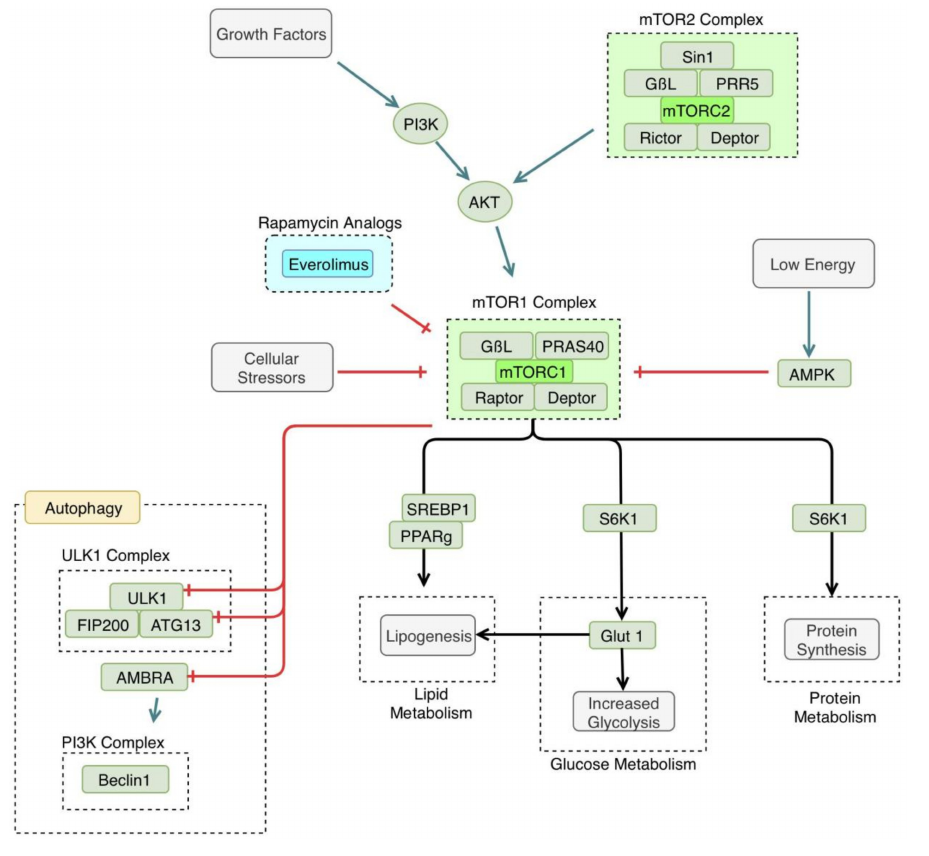
(AMP)-activated protein kinase, SREBP1: sterol regulatory element-binding protein 1, PPAR γ : peroxisome proliferatory-activated receptor γ , GLUT1: glucose transporter 1, FIP200: focal adhesion kinase family interacting protein of 200